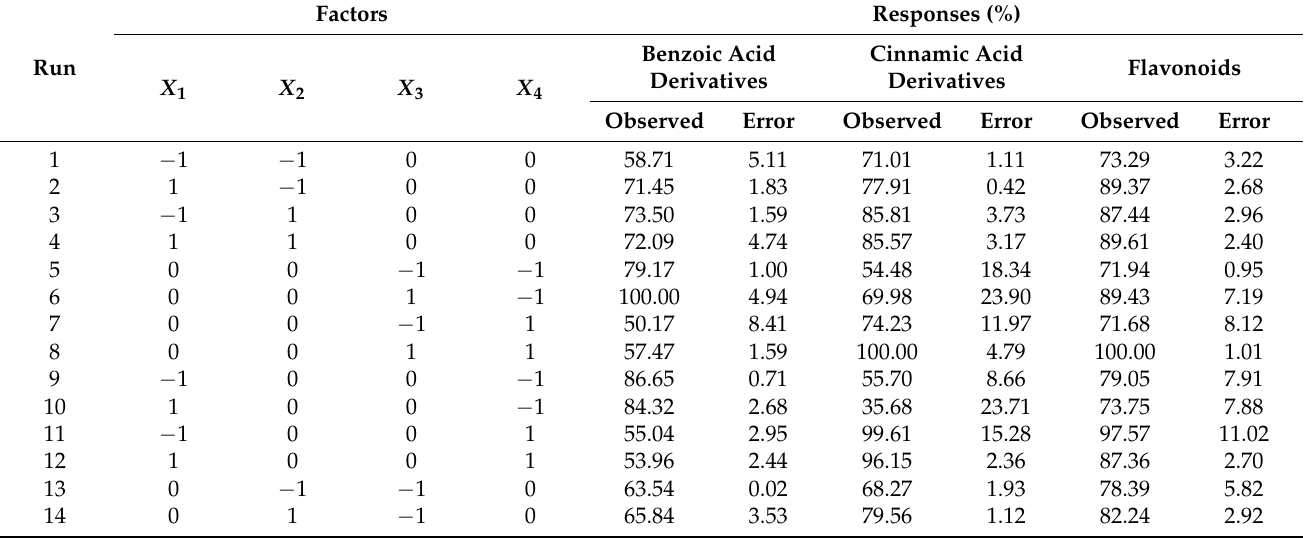
Table 1. Box–Behnken design with normalized measured responses * and the prediction